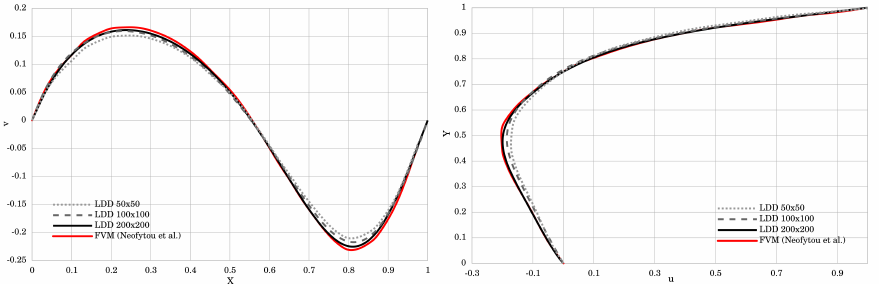
Figure 4. The velocity profile along the horizontal and vertical centerline of the square lid-driven cavity